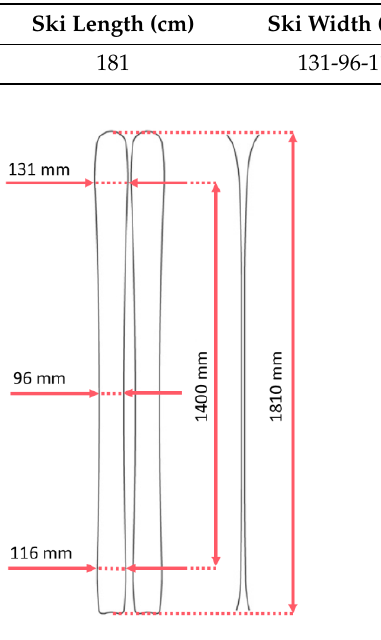
Table 1. Ski parameters.